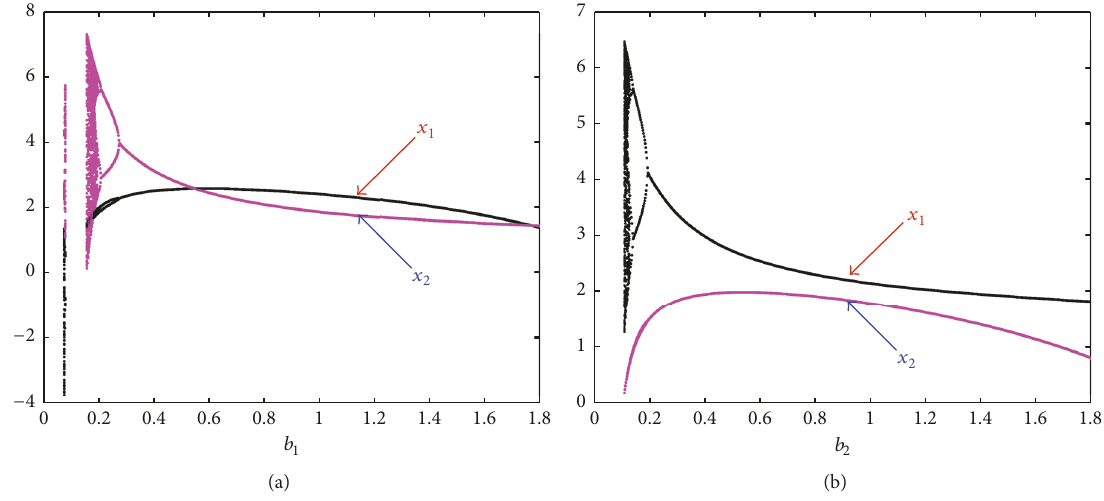
Figure 10: Bifurcation diagram for (a) 𝑏 1 ∈ (0,1.8] ; (b) 𝑏 2 ∈ (0, 1.8] and (𝛼 1 = 0.42, 𝛼 2 = 0.36)